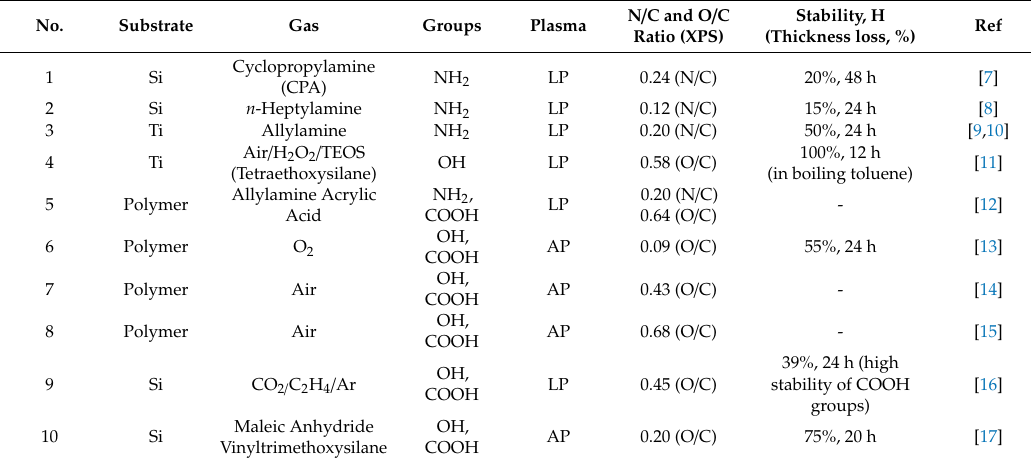
Table 1. Stability of functional groups formed at low-pressure (LP) and atmospheric-plasma (AP) plasma treatments. XPS: X-ray photoelectron